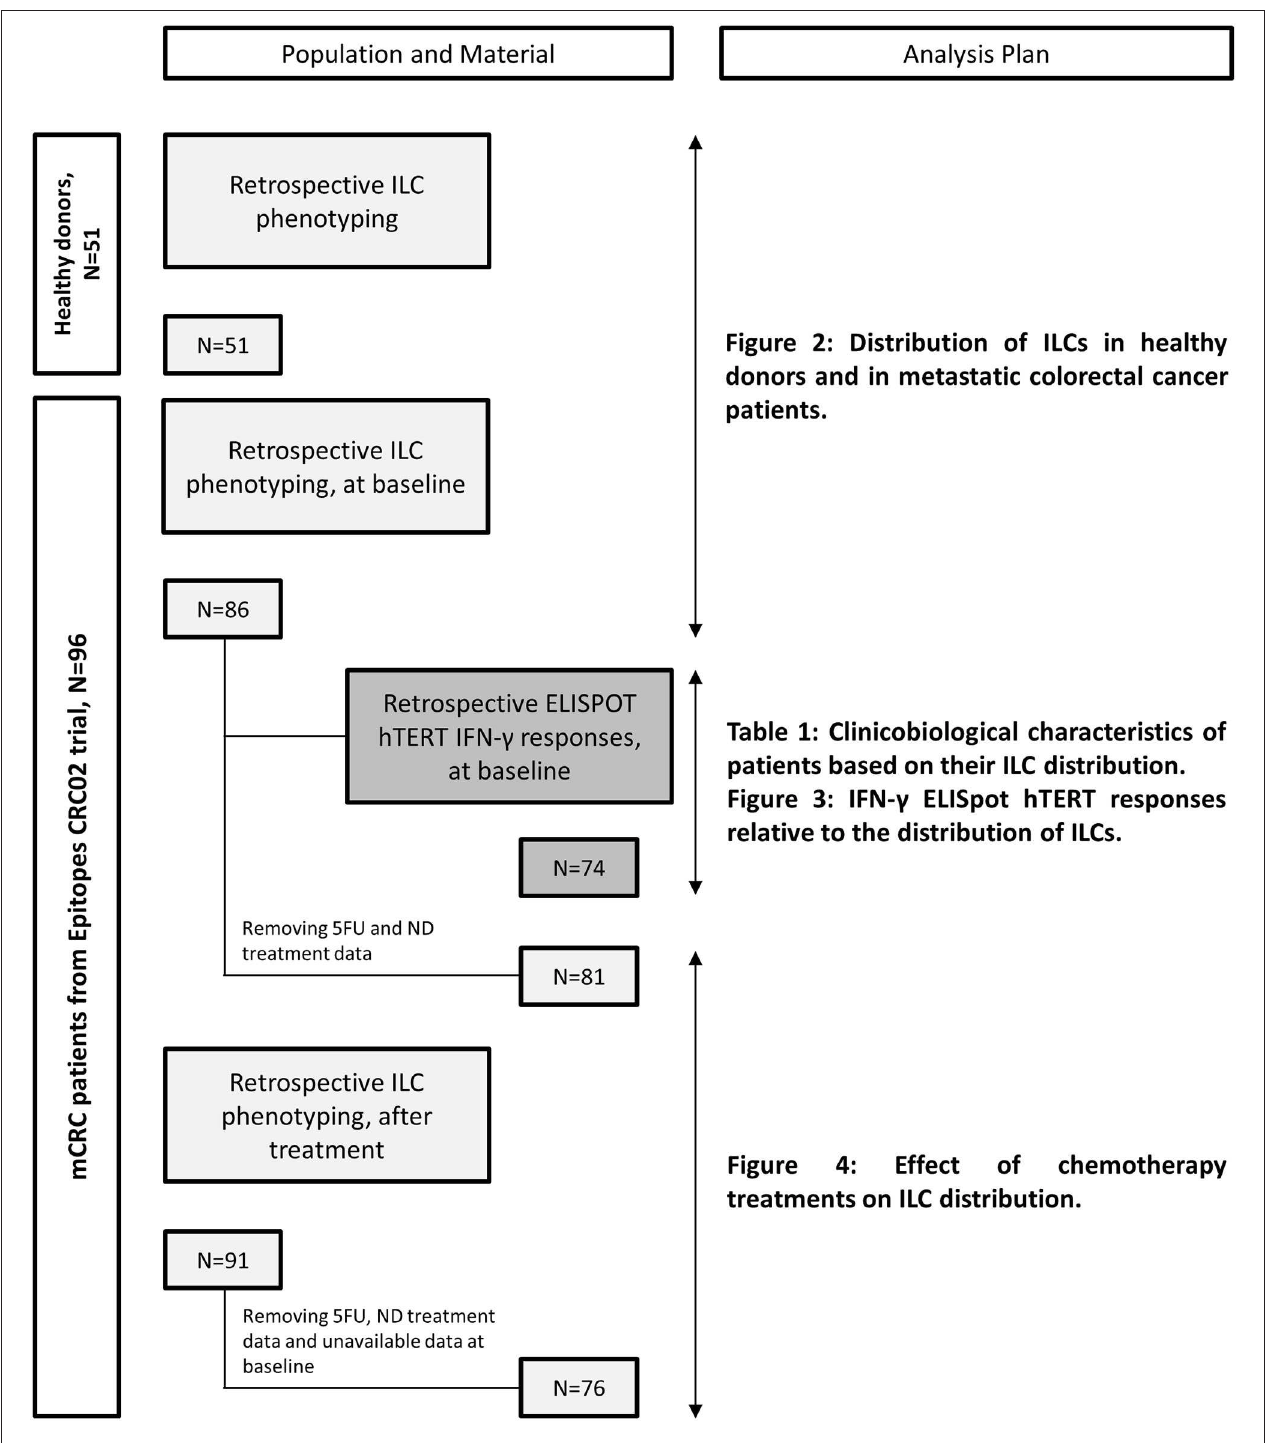
FIGURE 1 | Flowchart of available materials and analysis plan.